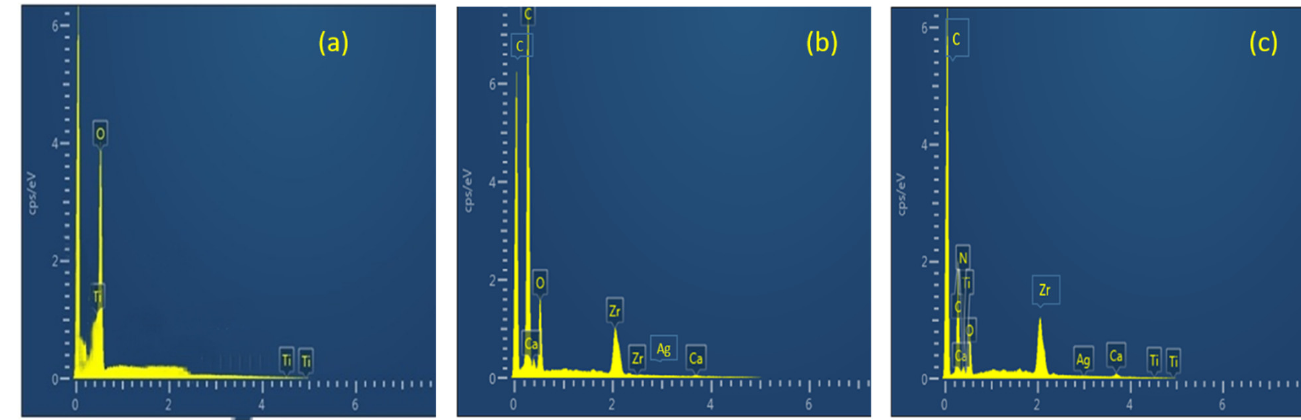
Figure 3. EDX spectra of ( a ) TiO 2 NP; ( b ) biomass; and ( c ) TiO 2 NC. Table 1. Element composition of biomass, TiO 2 NP & TiO 2 NC.